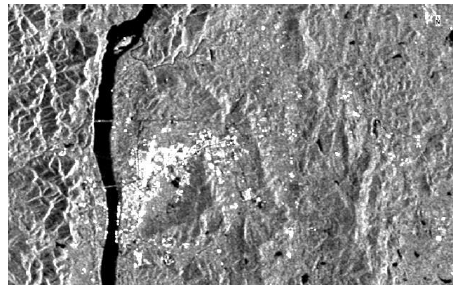
Figure 1. The Kuan filtered GF-3 SAR image